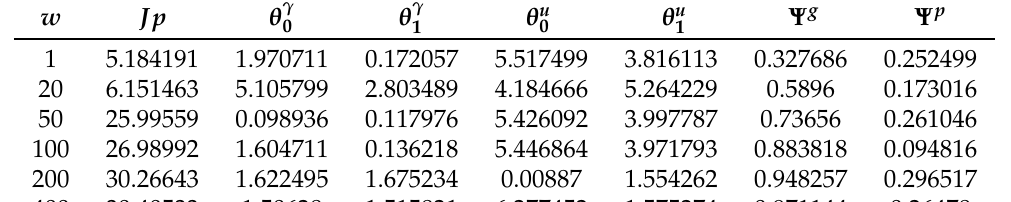
Table 4. Search evolution of QIGA.